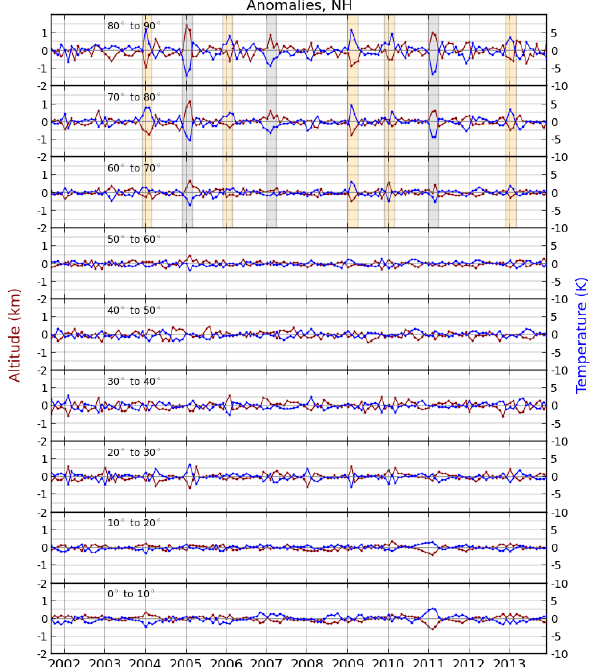
Figure 10. Anomalies of H T (red) and T T (blue) for 10 ◦ latitudinal bands in the SH. Time range: September 2001 to December 2013. Months with exceptionally warm/cool stratospheric conditions are highlighted in orange and gray,